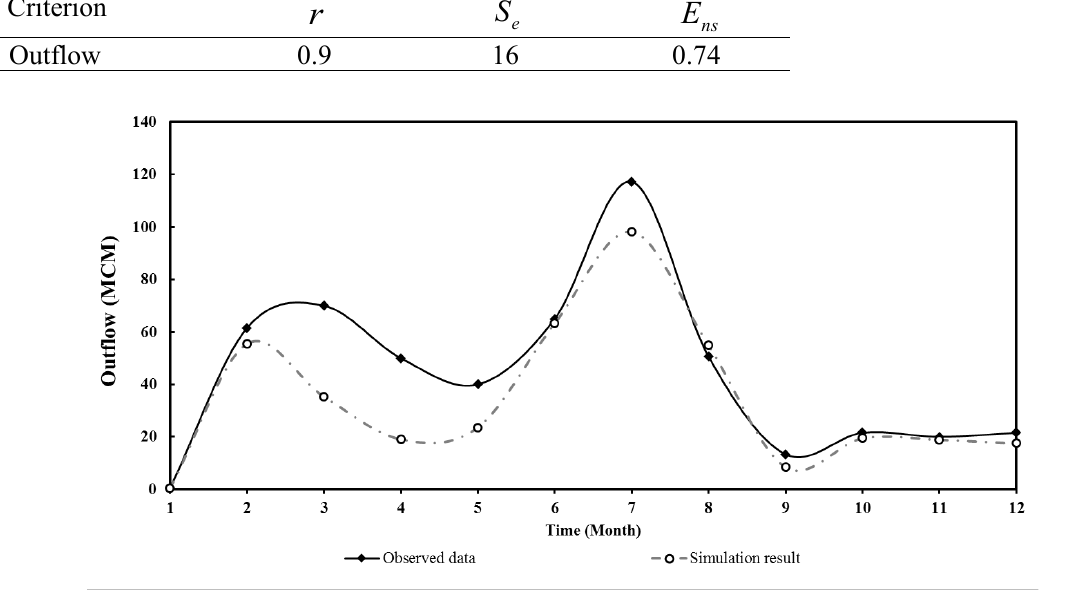
Figure 5. The observed and simulated Outflow of the Ilam watershed.